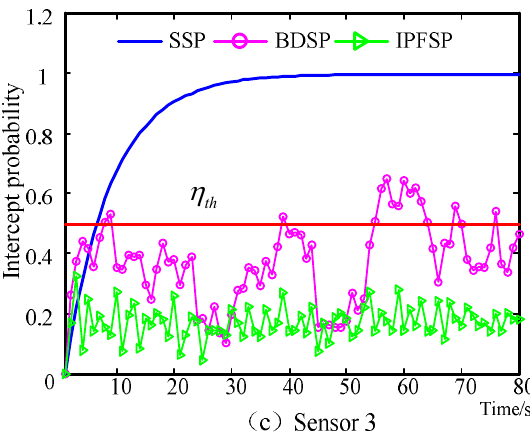
Figure 12. Sensor intercepted probability under different scheduling policies. ( a ) Sensor 1; ( b ) Sensor 2; ( c ) Sensor 3.